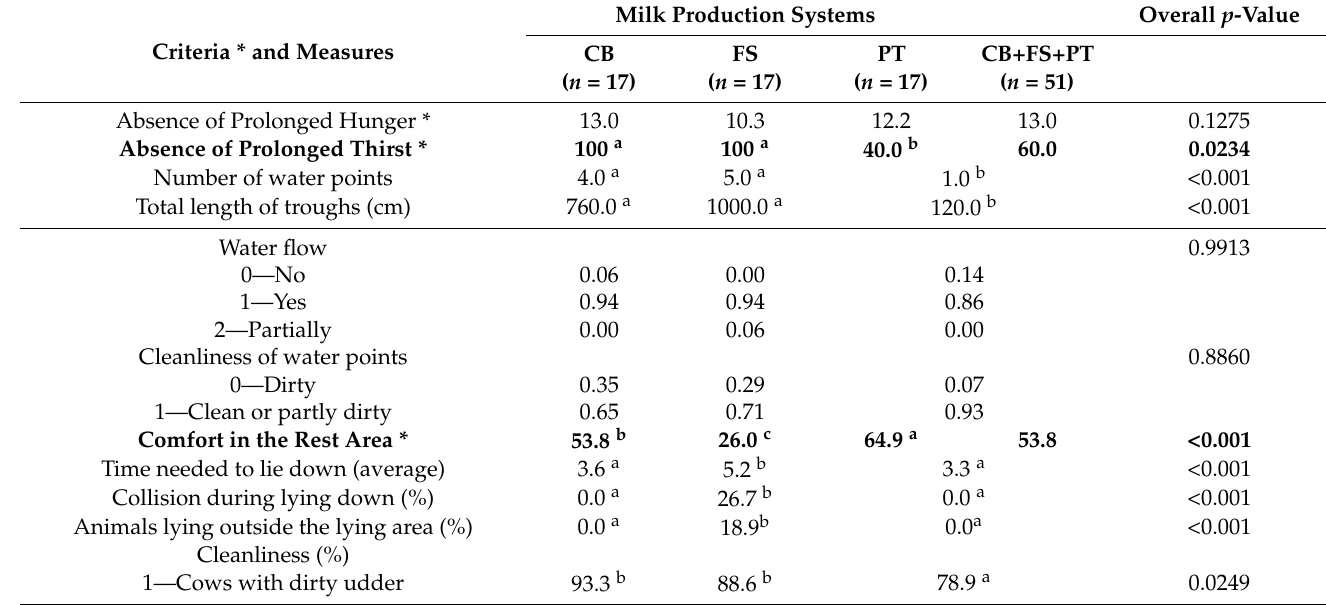
Table 1. Scores of the criteria and measures of the Welfare Quality ® protocol in the compost